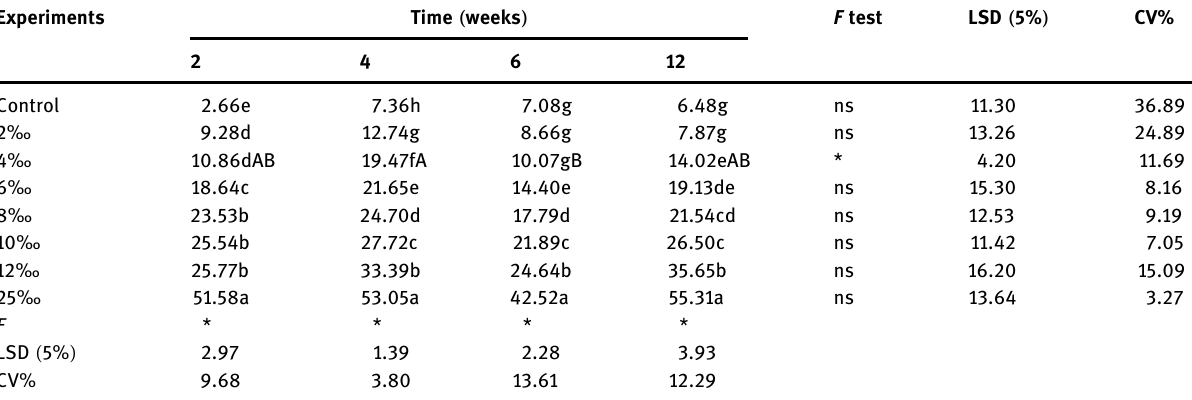
Table 6: E ff ect of salt concentration and treatment duration on percentage of exchangeable Na ( ESP ) in the soil Experiments Time ( weeks )